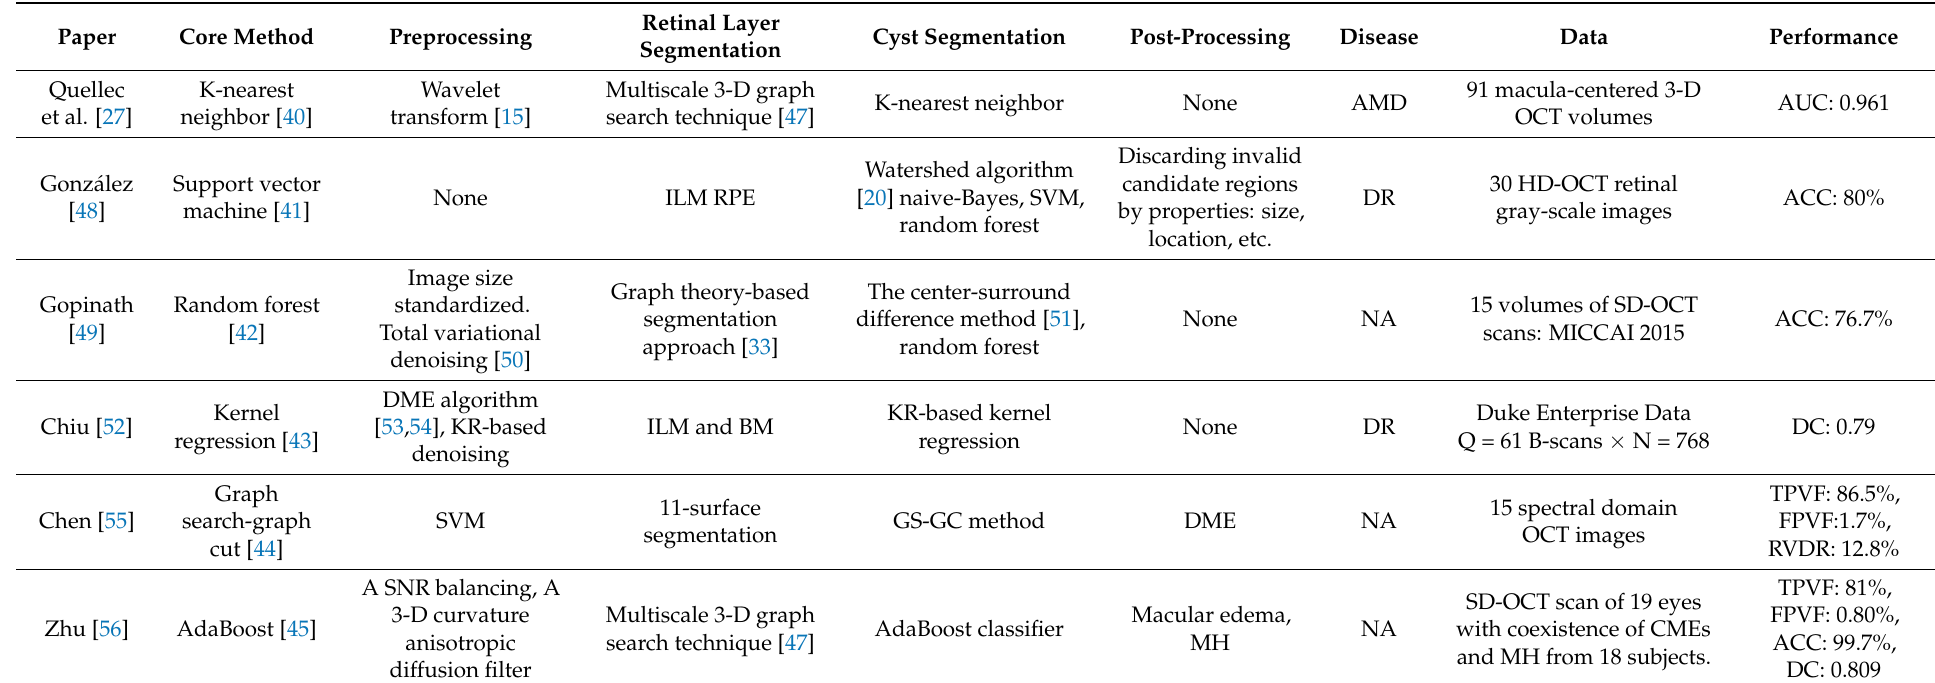
Table 1. Classical machine learning methods for cyst